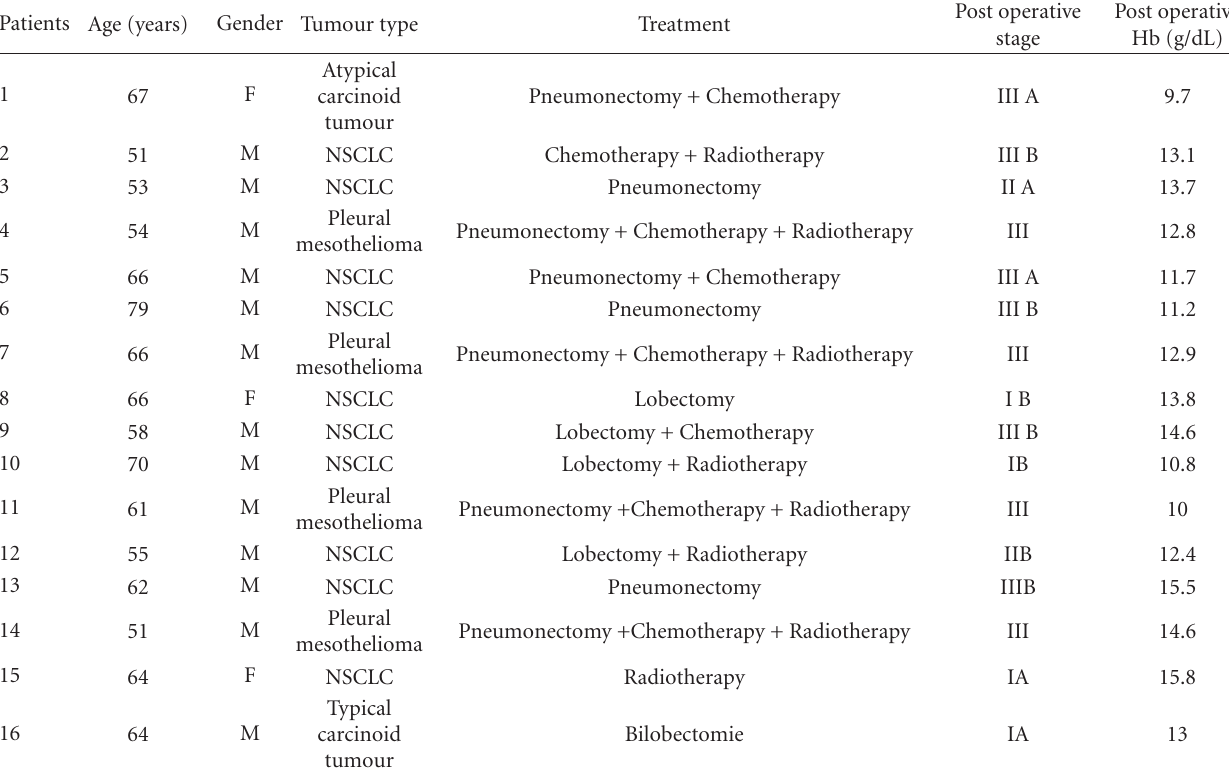
NSCLC: Non Small Cell Lung Cancer.